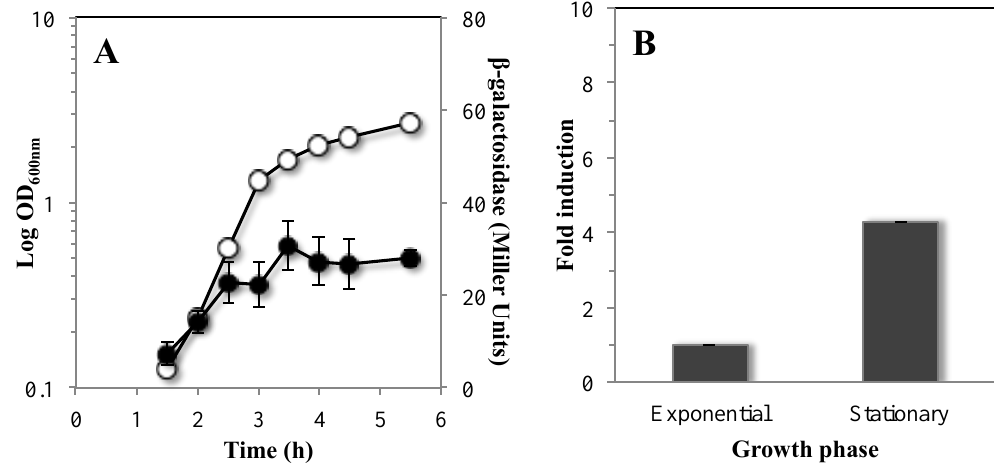
Figure 5. Analysis of Mfd expression during the growth cycle of B. subtilis. ( A ) Levels of β-galactosidase of a mfd-lacZ transcriptional fusion were measured during the exponential and stationary phase of growth. B. subtilis strain PERM1123 was grown in liquid antibiotic (A3) medium. Cell samples were collected at the indicated times and treated with lysozyme, and the extracts were assayed for β-galactosidase as described in Materials and Methods. Data shown are average values from triplicate independent experiments SD for β-galactosidase specific activity (●) and for A 600nm values ( ○ ). ( B ) Relative fold change of mfd mRNA levels in YB955 strain determined by qRT-PCR assays. Levels of mRNA from cultures in exponential growth were compared to stationary phase mRNA levels. The veg gene was used to standardize expression. The data shown are average values for triplicate independent experiments ± standard deviations (SD).